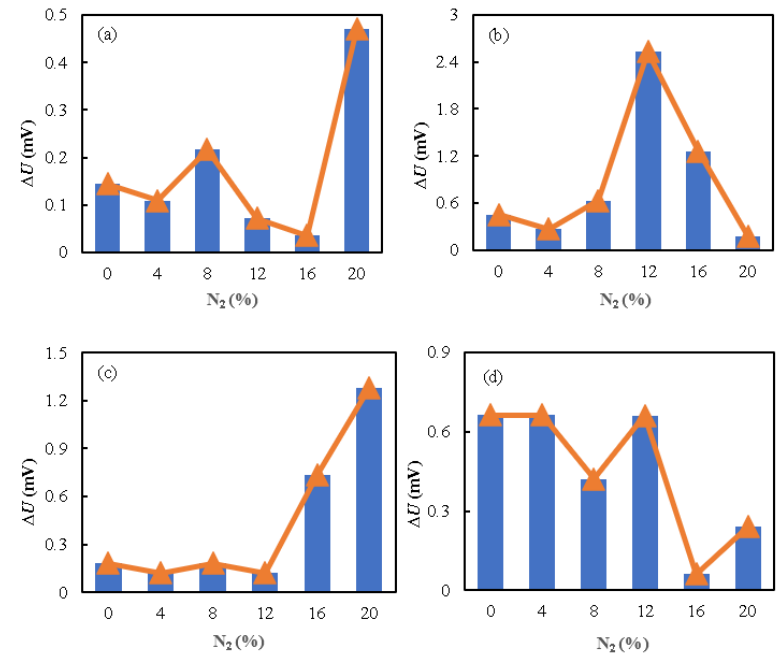
Figure 10. Fitting results of cell 4 at different current densities: ( a ) 0.2 A ∙ cm − 2 ; ( b ) 0.6 A ∙ cm − 2 ; ( c ) 1.0 A ∙ cm − 2 ; ( d ) 1.4 A ∙ cm − 2 .